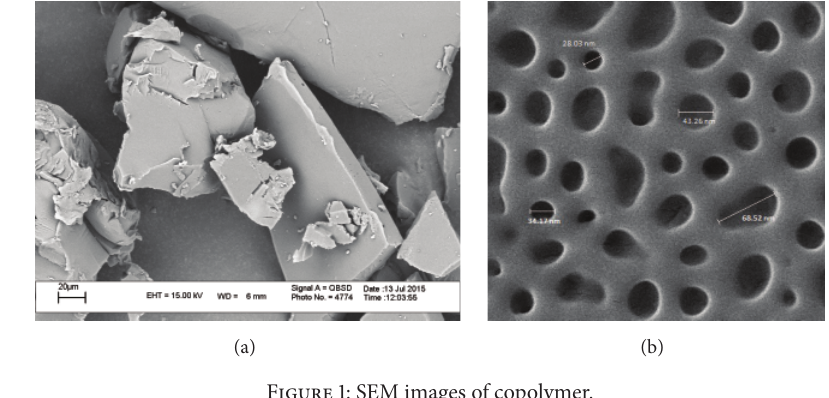
Figure 1: SEM images of copolymer.